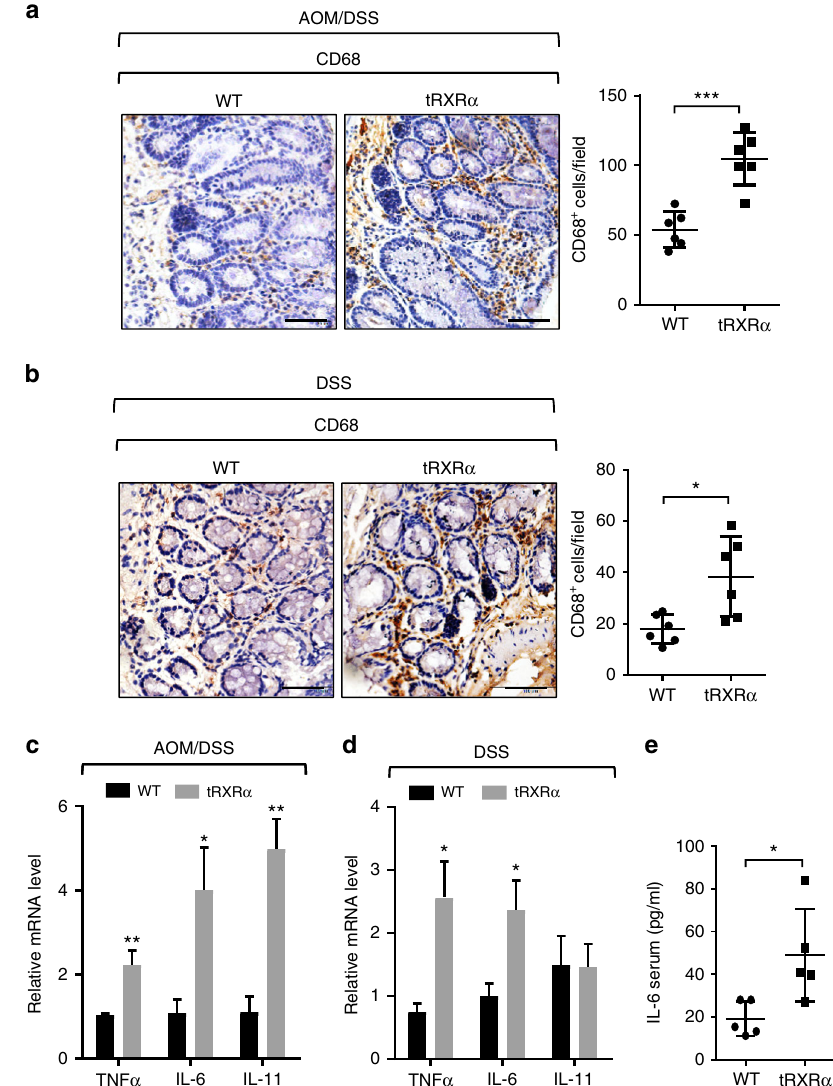
Fig. 3 Increased in fi ltration of in fl ammatory cells and cytokine production in Tg-tRXR α tumor. a , b Colonic sections from mice treated with azoxymethane (AOM)/dextran sodium sulfate (DSS) ( a ) or DSS ( b ) were stained with CD68 antibody to detect macrophages and analyzed for the number of CD68- positive cells per fi eld (scale bars, 50 μ m). Each dot represents a mouse, 10 fi elds were counted per mouse. Data are mean ± SD ( n = 6), t test. c , d Relative mRNA expression levels of the indicated genes in colon of mice treated with AOM/DSS ( c ) or DSS ( d ) were determined by quantitative reverse transcriptase – PCR. Data are mean ± SEM ( n = 4), t test. e Serum levels of interleukin-6 from mice treated with 3% DSS for 2 days were measured by enzyme-linked immunosorbent assay. Each dot represents a mouse. Data are mean ± SD ( n = 5), t test. * P < 0.05, ** P < 0.01, *** P <